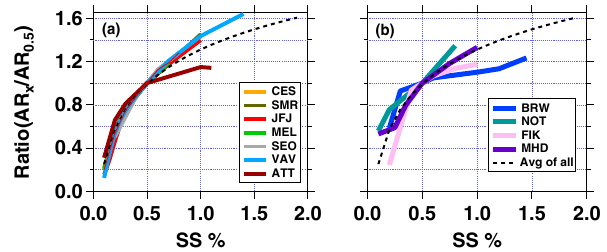
Figure 6. Ratio of activation ratios for all measured SS (%) over the activation ratio at 0.5%SS for each station. At SS = 0.5% ( x - axis) the ratio is 1. Activation ratios are based on particle size distributions starting at 20nm. (a) Shows non-coastal sites, while (b) groups all coastal sites. The black dotted line is the average fit through all curves from (a) and (b) , whereby y = A · ln(SS%) + b with A = 0.46 ± 0.02 and b = 1.31 ±